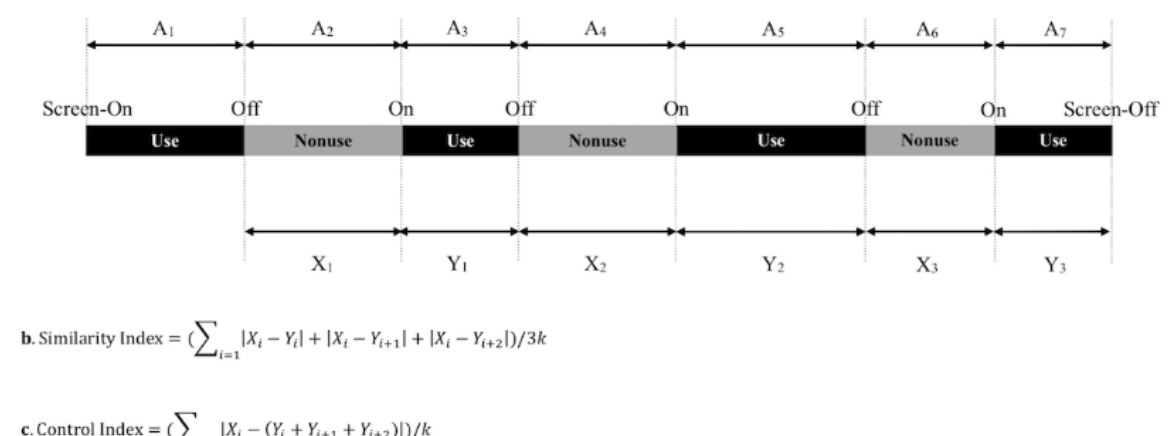
Figure 1. Use/nonuse reciprocity parameters. (a) A schematic and the equation used to calculate the root mean square of the successive differences (RMSSD). Ai is the duration of a use or nonuse epoch. There are (n-1) successive differences of use/nonuse episodes. The RMSSD was calculated to be the square root of the mean square. (b) A schematic and the equation used to calculate the Similarity Index (SI), Xi refers to the duration of a nonuse (gray) episode, Yi refers to the duration of a use (black) episode. Each nonuse episode (Xi) corresponds to 3 successive use epochs (Yi, Yi+1, and Yi+2). k is the number of nonuse episodes in a day. Thus, the SI is the average absolute difference between the nonuse and use episodes. (c) A schematic and the equation used to calculate the Control Index (CI), Xi refers to the duration of a nonuse (gray) episode and Yi refers to the duration of a use (black) episode. Each nonuse episode (Xi) corresponds to 3 successive use epochs (Yi, Yi+1, and Yi+2). k is the number of nonuse episodes in a day. Thus, the CI is the average of the absolute differences between 1 nonuse episode and the total of the following 3 use episodes. RMSSD: root mean square of the successive